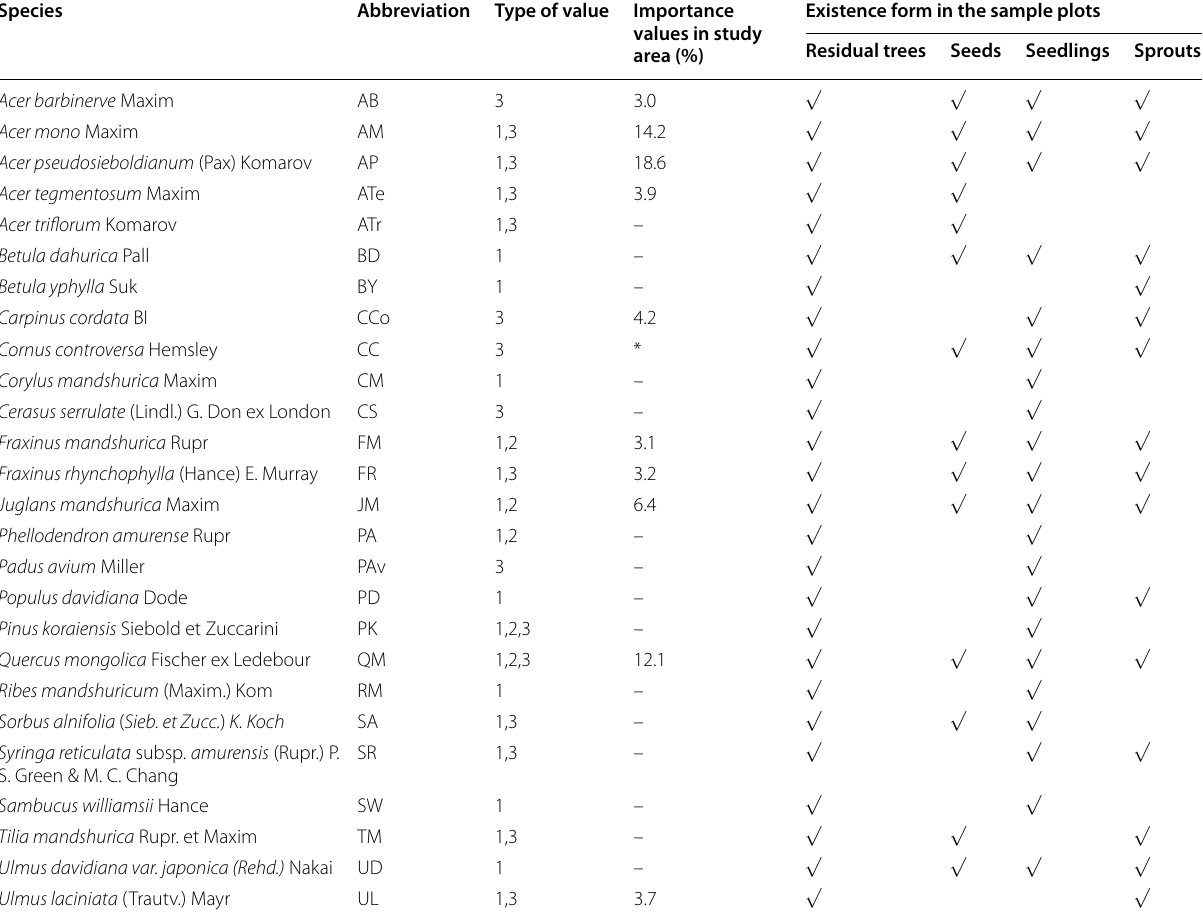
Table 1 Tree species information of selected stands in secondary